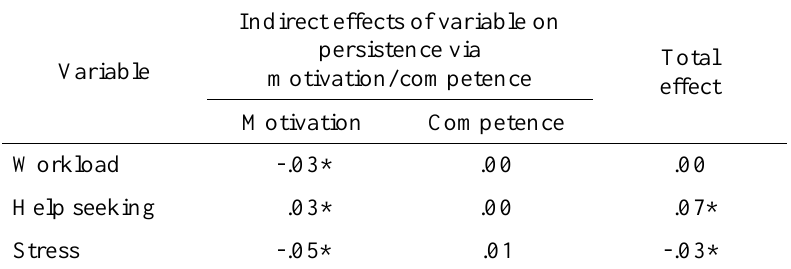
Indirect and Total Effects on